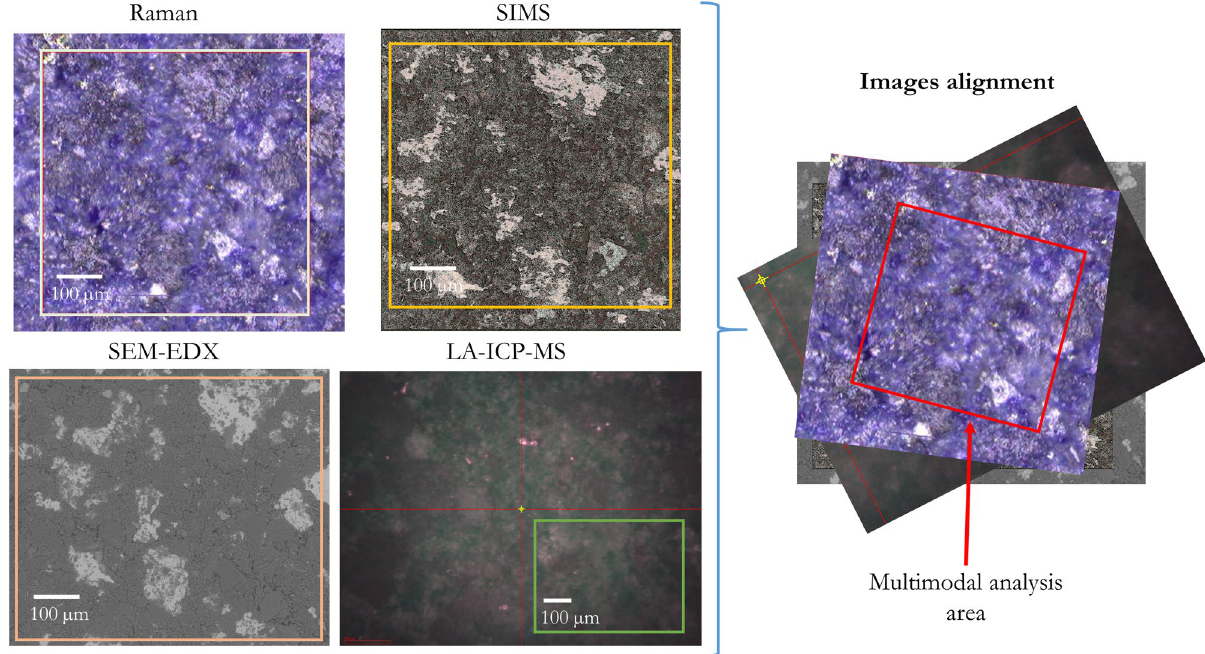
Figure 1. Images of NU-2 sample analyzed with each of the individual techniques (left) and alignment of all datasets via affine transformation (right). Regions not contained within the red square marking overlapping areas of all four imaging techniques were excluded from the multisensor hyperspectral